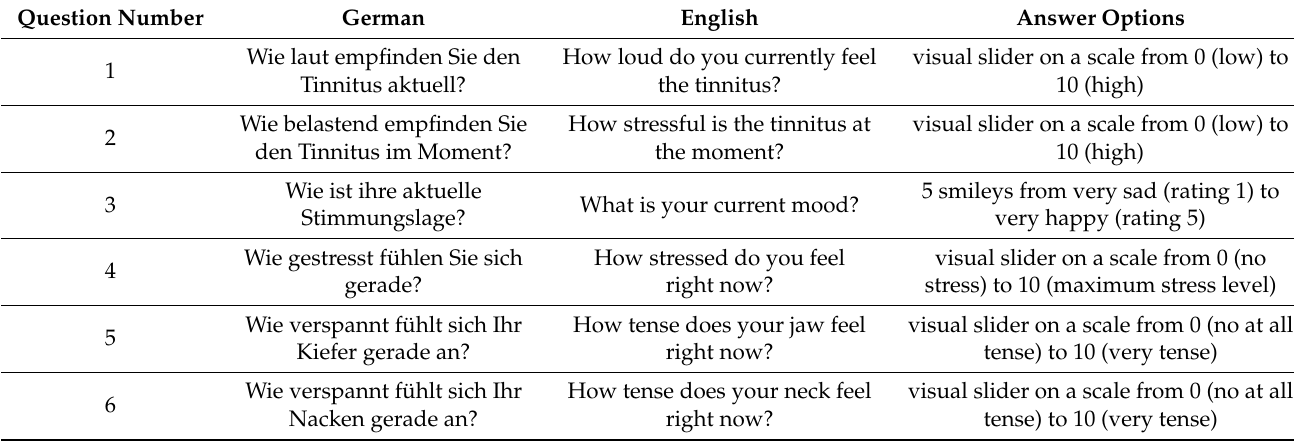
Table 1. Questions for ecological momentary